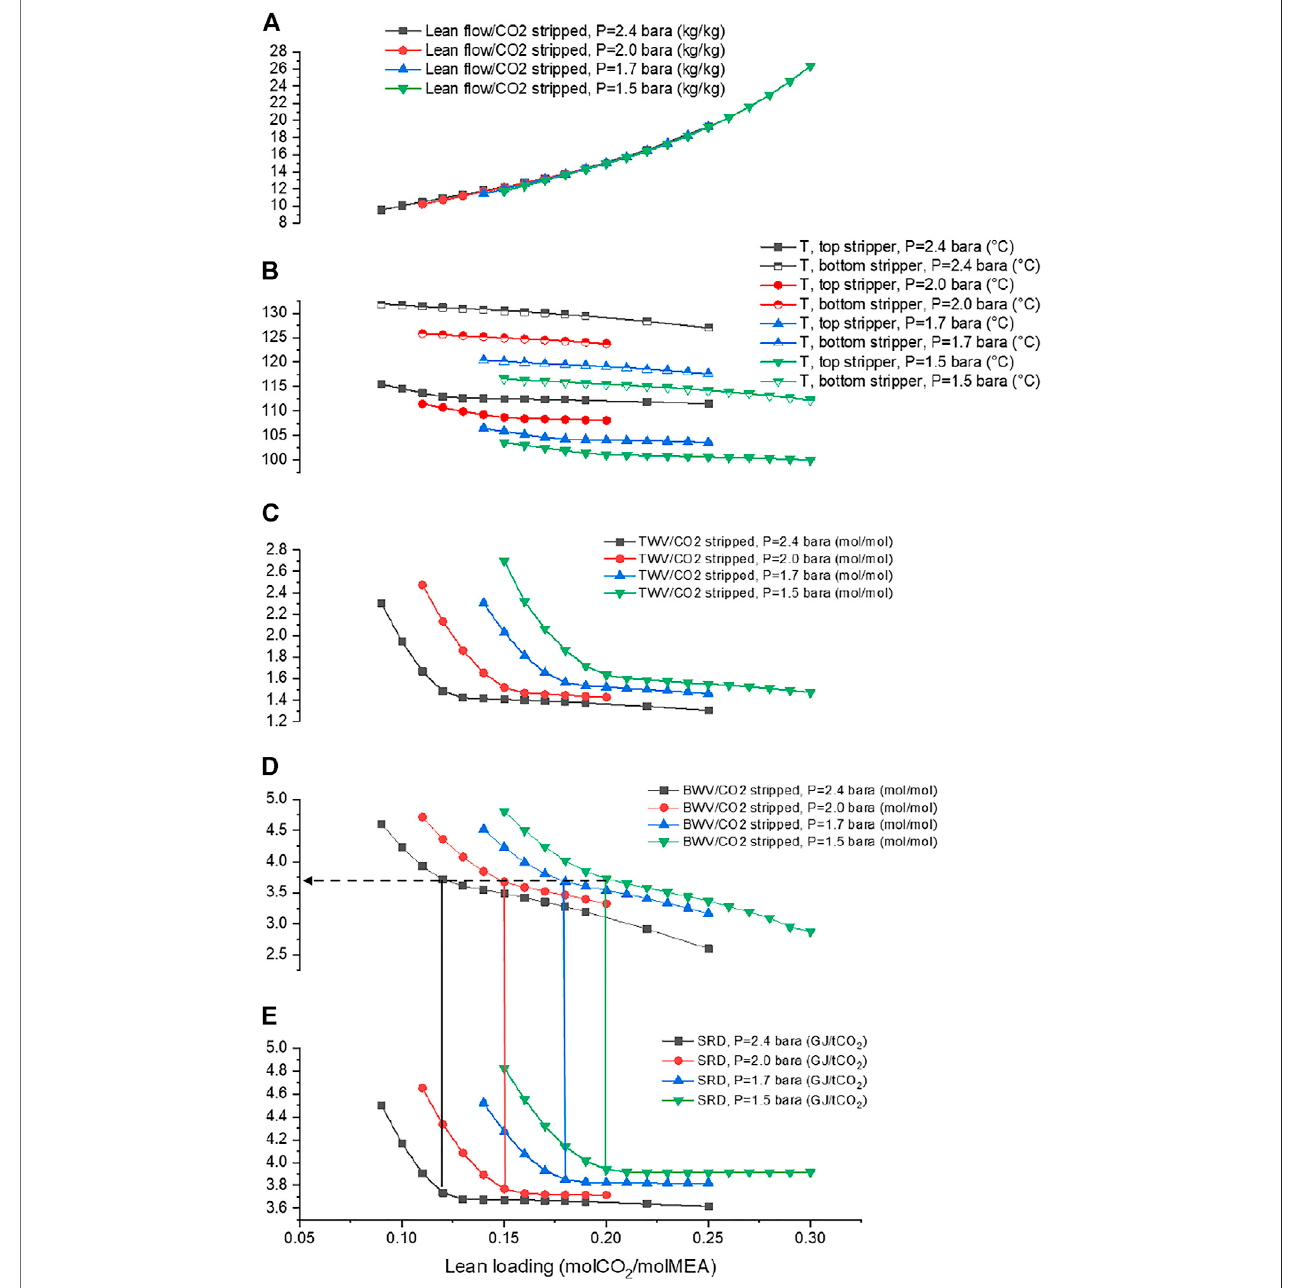
FIGURE 3 | Thermodynamic investigation of the stripper for different operating pressures and as a function of the lean loading. Rich loading is 0.446 molCO 2 / molMEA with a constant capture level of 95%, corresponding to a capture rate of 39.985 kgCO 2 /s.